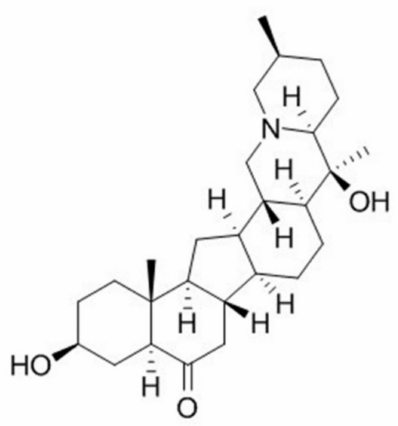
Figure 1. Chemical structure of peiminine